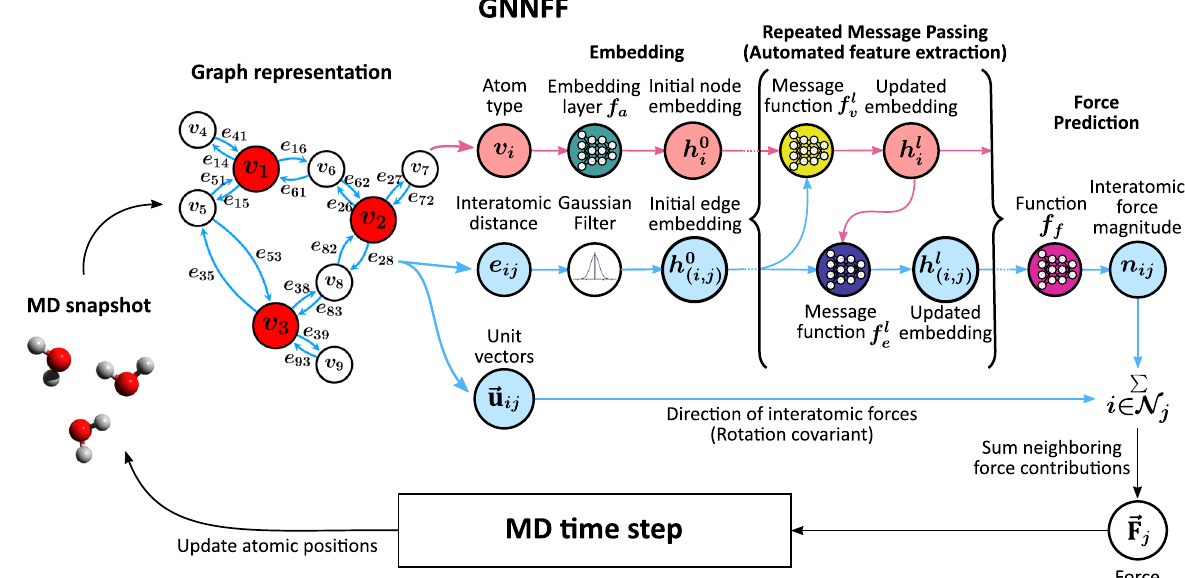
Fig. 1 Illustration of the GNNFF architecture. Each atomic con fi guration is represented as a directed graph that is then used as the input for GNNFF. Atom i is represented as node ν i and the in fl uence atom i has on atom j is represented by a directed edge e ij . The direction of this ! in fl uence is represented by unit vector u ij . Nodes and edges are embedded with latent vectors in the embedding stage. Initially, the node and edge embeddings respectively contain the atom type and interatomic distance information. The embeddings are then iteratively updated during the message passing stage. The fi nal updated edge embeddings are used for predicting the interatomic force magnitudes. The force on the center atom j is calculated by summing the force contributions of neighboring atoms i 2 N j that are calculated by multiplying the force magnitude and the respective unit vector. The predicted forces are fi nally used for updating the atomic positions in